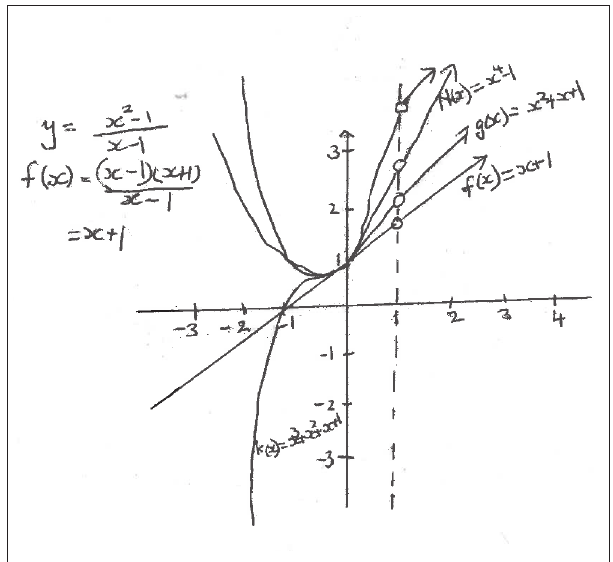
FIGURE 2: Hand plots of y